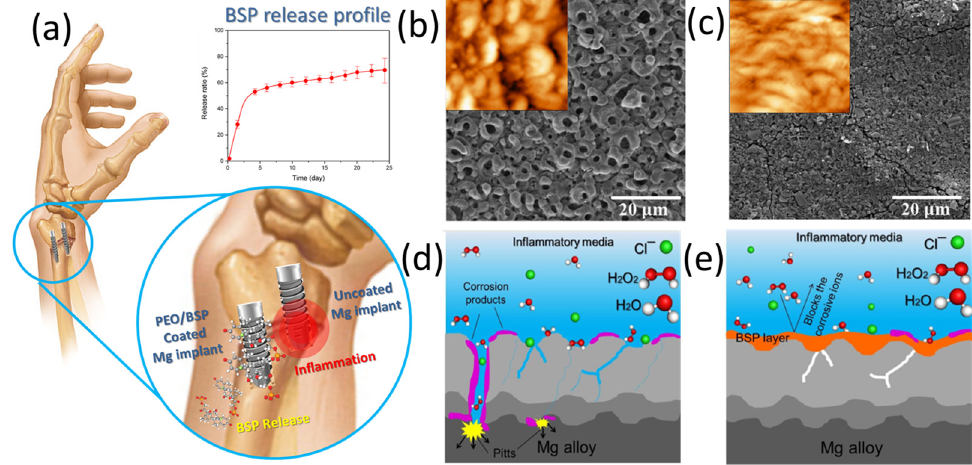
Figure 2. ( a ) The schematic illustration and release profile of PEO/BSP coating on Mg alloy; Scan- ning electron and atomic force micrographs of ( b ) PEO, and ( c ) PEO/BSP coatings; The corrosion performance of Mg implants with different coatings in simulated inflammatory condition: ( d ) PEO, and ( e ) PEO/BSP coatings. Reprinted with permission from the reference [53].